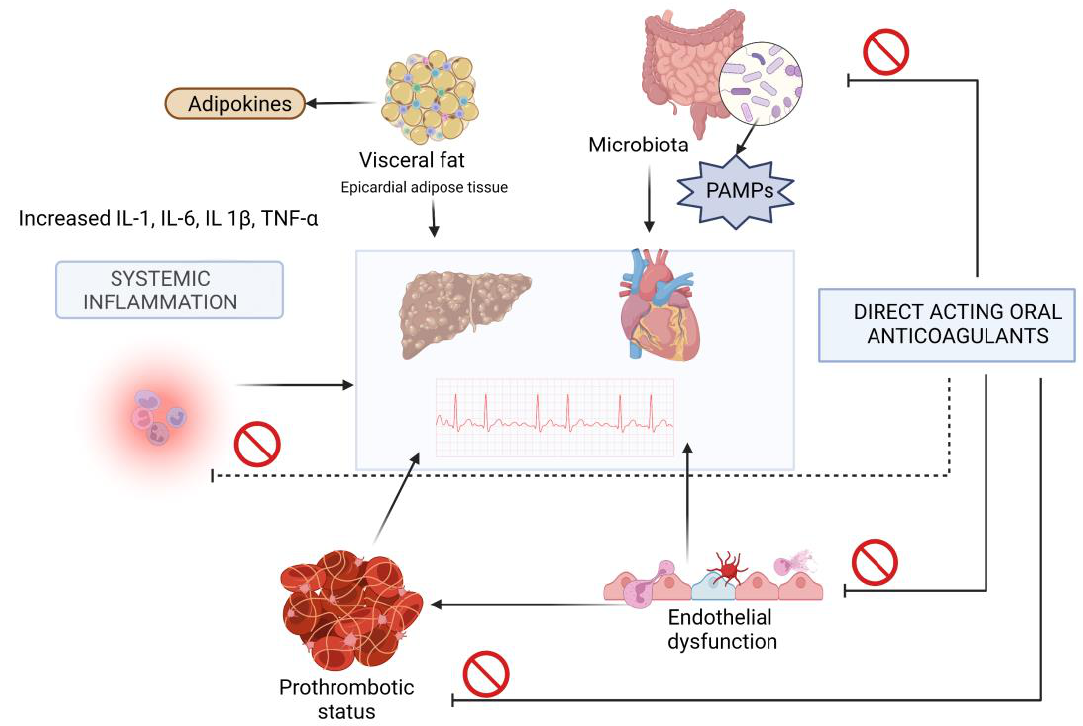
Figure 1. Physiopathology of atrial fibrillation in liver cirrhosis.